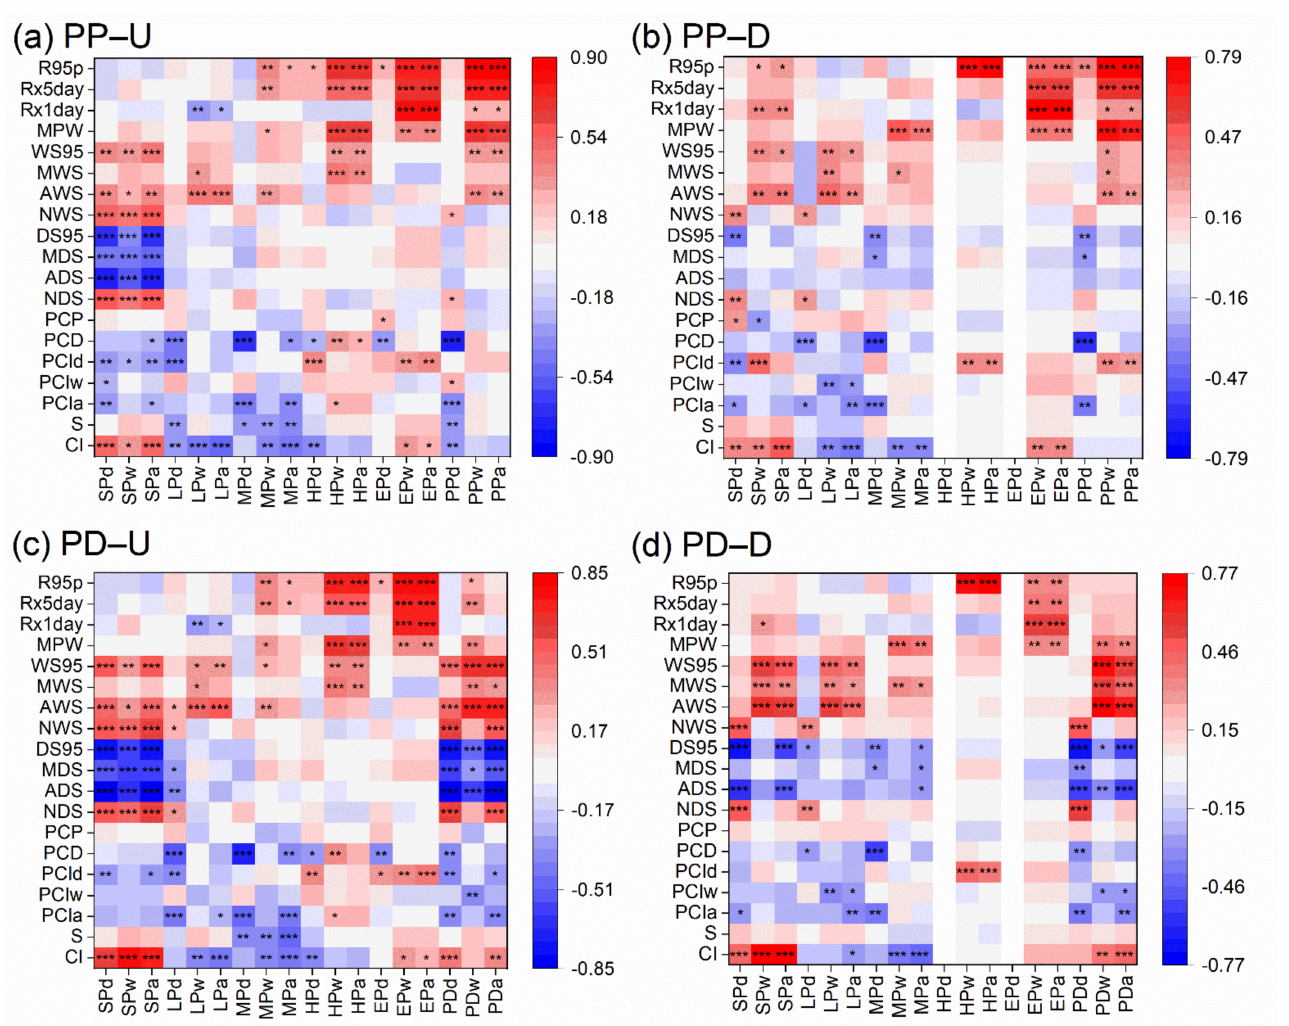
Figure 6. Relationship between ( a ), ( b ) precipitation/ ( c ), ( d ) rainy days with each intensity in different scales and indices with distribution concentration & characteristics of wet/dry spell over the basin during 1977–2017. –U is the value for the upper basin; –D is the value for the lower basin. –d is the value in the dry season, w is the value in the wet season, a is the value for annual. * Correlation is significance at 0.1 level; ** correlation is significance at 0.5 level; *** correlation is significance at 0.01